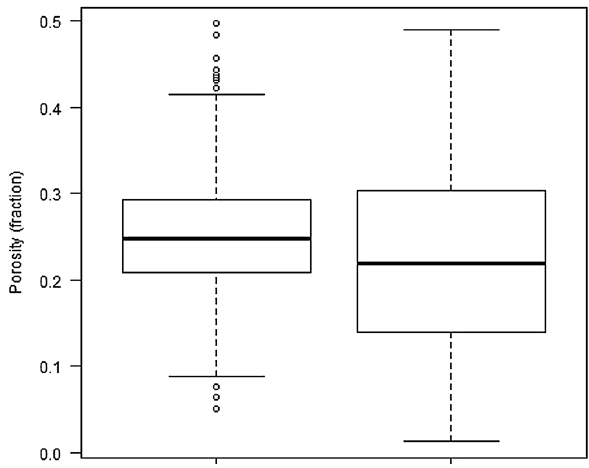
Fig. 14 Box plots of Horizon X individual porosity values (left) and Horizon Y individual porosity values (right)